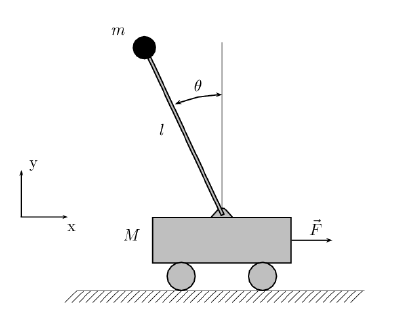
Figure 2. Representation of an inverted